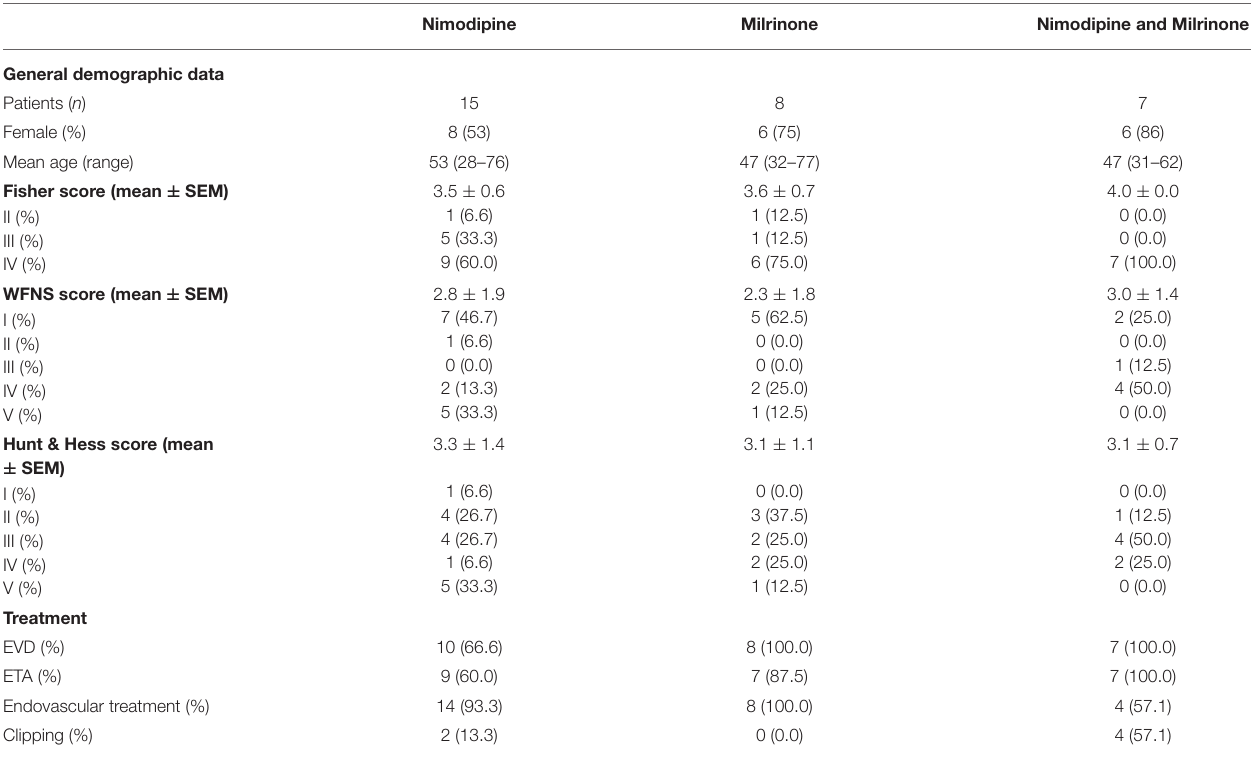
TABLE 1 | Baseline